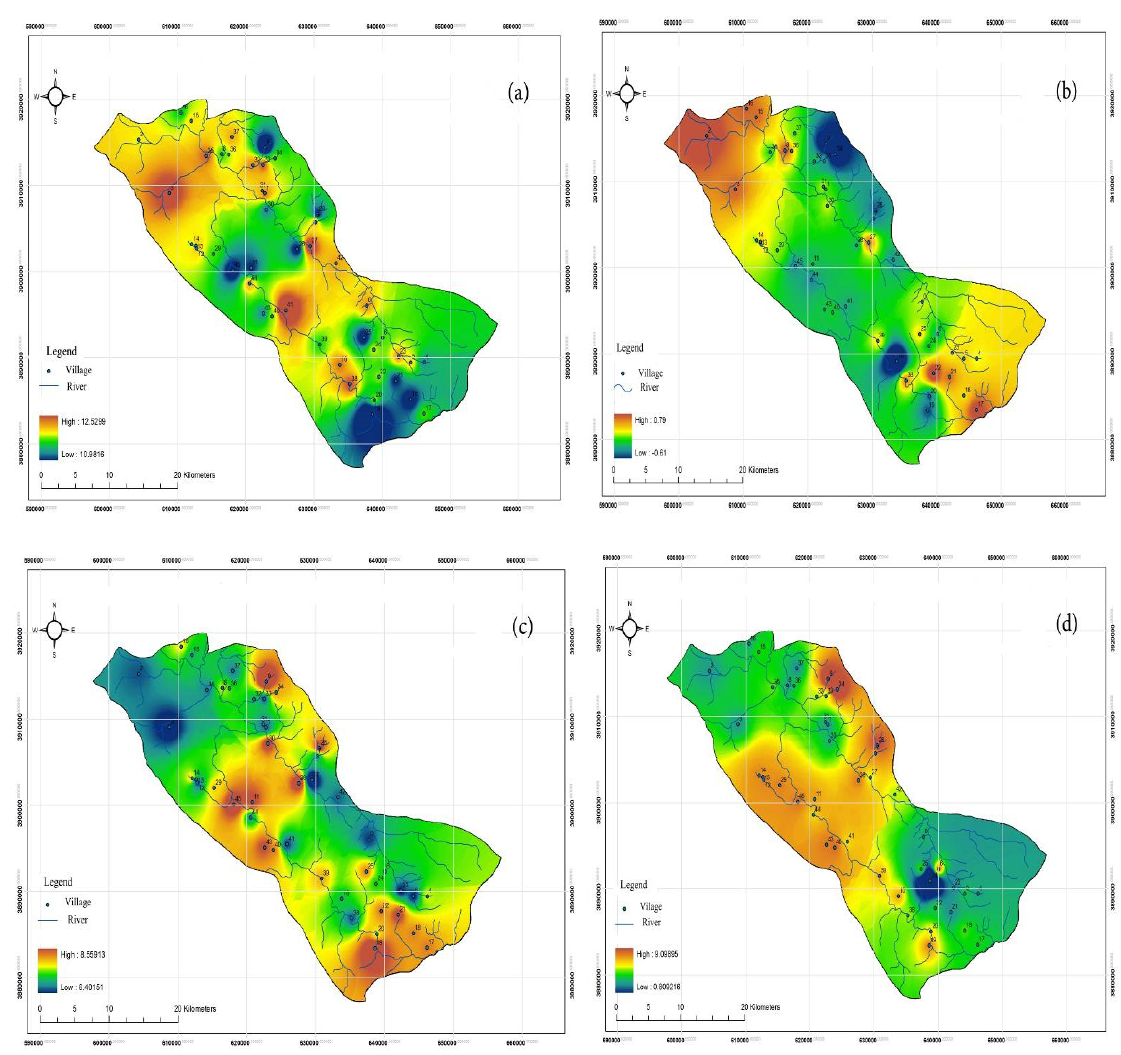
Fig. 2. Spatial distribution of water resources based on different indices during a low rain season (fall): a) AI, b) LSI, c) RI, and d)